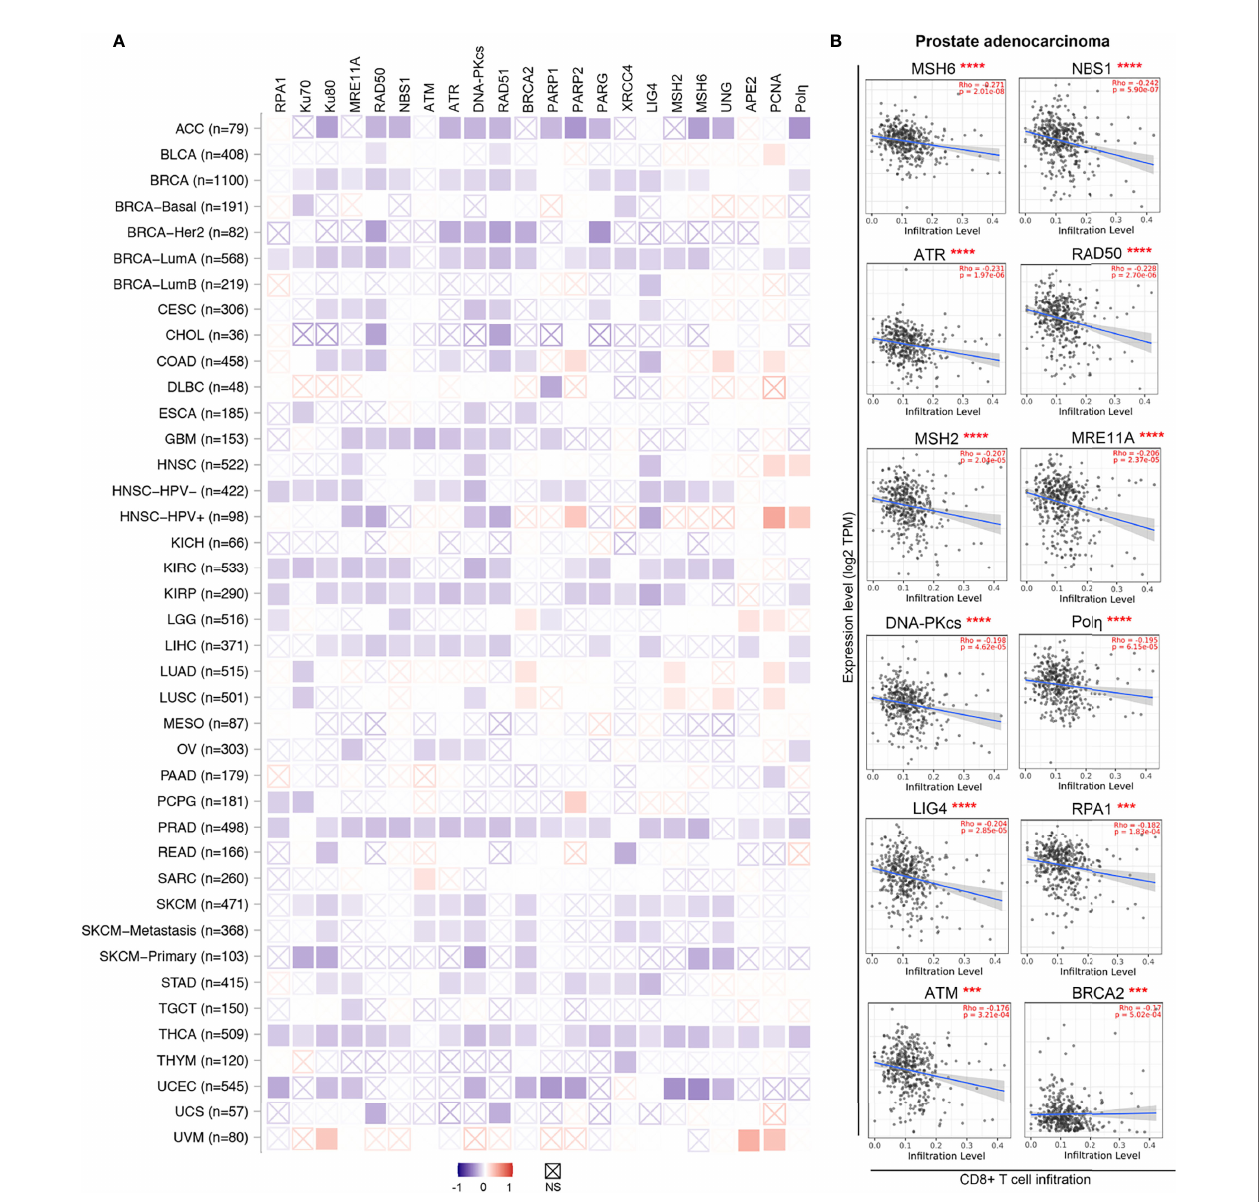
FIGURE 3 | DDR factors negatively associate with CD8+ T cells in fi ltration levels in diverse cancer types. (A) A heatmap based on the CIBRSORT method shows the purity-adjusted Spearman ’ s rho of DDR factors with CD8+ T cells across various cancer types. The boxes with indicate non-signi fi cant p values (p>0.05). The fi gures was made using the TIMER2.0 web server based on CIBRSORT analysis (http://timer.cistrome.org/). (B) Detailed correlation between DDR factors and CD8+ T cells in prostate adenocarcinoma (PRAD) from panel (A) The purity-adjusted Spearman ’ s rho and p value are labeled in red. ***p < 0.001; ****p <